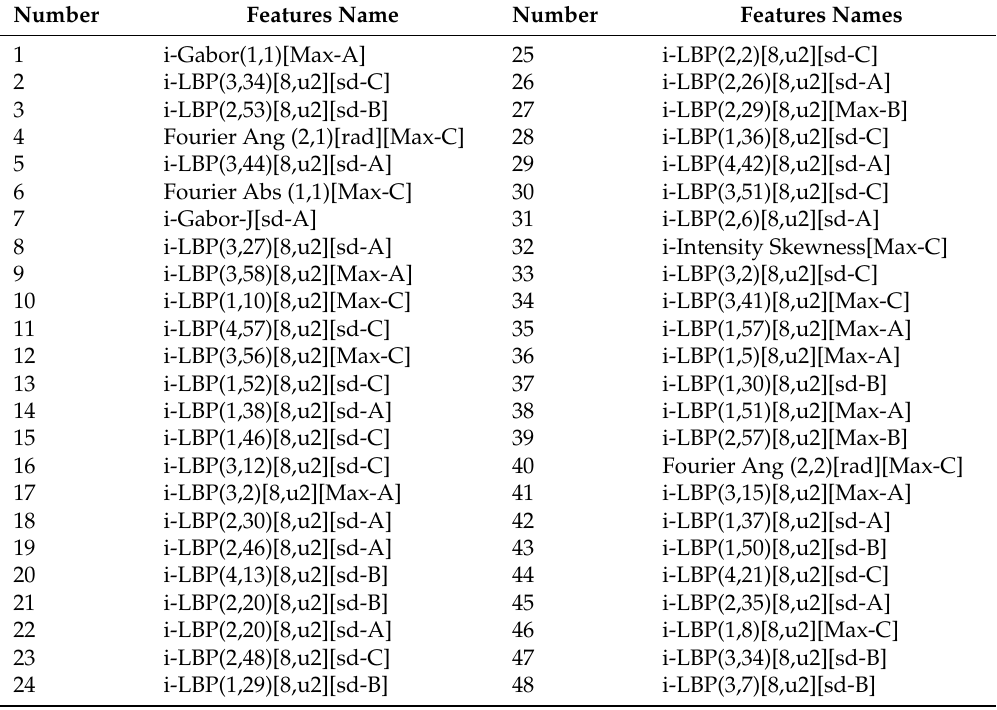
Table 4. The selected features used by LDA classifier applying the sequential forward selection (SFS) method and the Fisher score objective